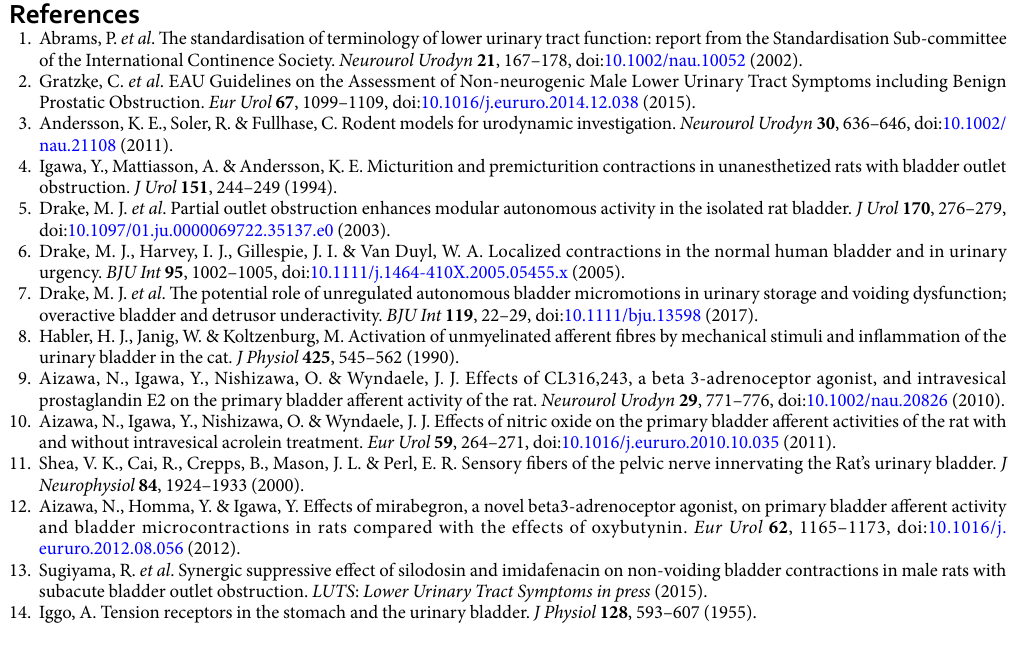
and at 10 ml/h in the BOO rats (at day 10). Such different rates of saline-instillation may affect the development of microcontractions or SAAs, but our preliminary investigation showed that there were no remarkable differences in the microcontractions or SAAs between the different rates (data not shown). The filling continued until an intravesical pressure of 30 cmH 2 O was achieved, and the bladder compliance was simply calculated between the start and end of the saline-instillation into the bladder during measurements. The SAAs were expressed as the firing rates (Hz) and evaluated in relation to intravesical pressure at each 5 cmH 2 O-interval. A microcontraction was defined as a contraction with an amplitude of more than 2 cmH 2 O, and where intra- vesical pressure was ascending at 0.25 cmH 2 O/s or more and then descending at 0.15 cmH 2 O/s or more. The microcontraction was divided into two phases: “ascending” and “descending”. The portion between the two microcontractions was termed as the “stationary” phase (Fig. 5). Statistical Analyses. All data are expressed as mean ± SEM. The results between the Sham and BOO rats were analyzed using an unpaired Student’s t -test. To evaluate the SAAs related with microcontractions, repeated measures ANOVA followed by Tukey’s multiple comparison test was used. P values < 0.05 were considered sta- tistically significant.